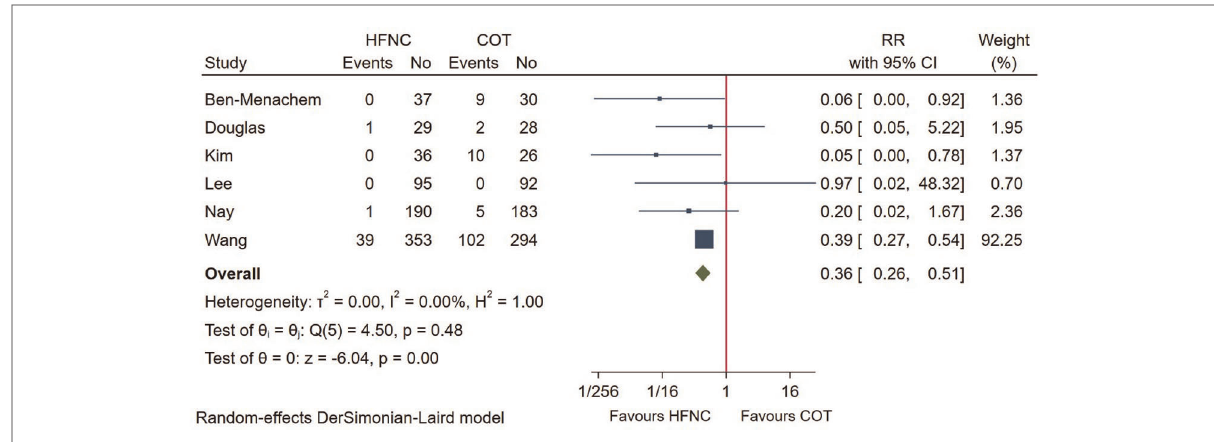
FIGURE 6 Forest plot comparing procedure interruption during the procedure in HFNC versus COT. HFNC, high fl ow nasal cannula; COT, conventional oxygen therapy; RR, risk ratio.